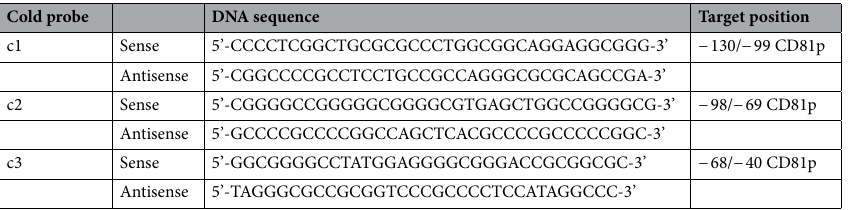
Table 2. DNA sequence of cold probe for